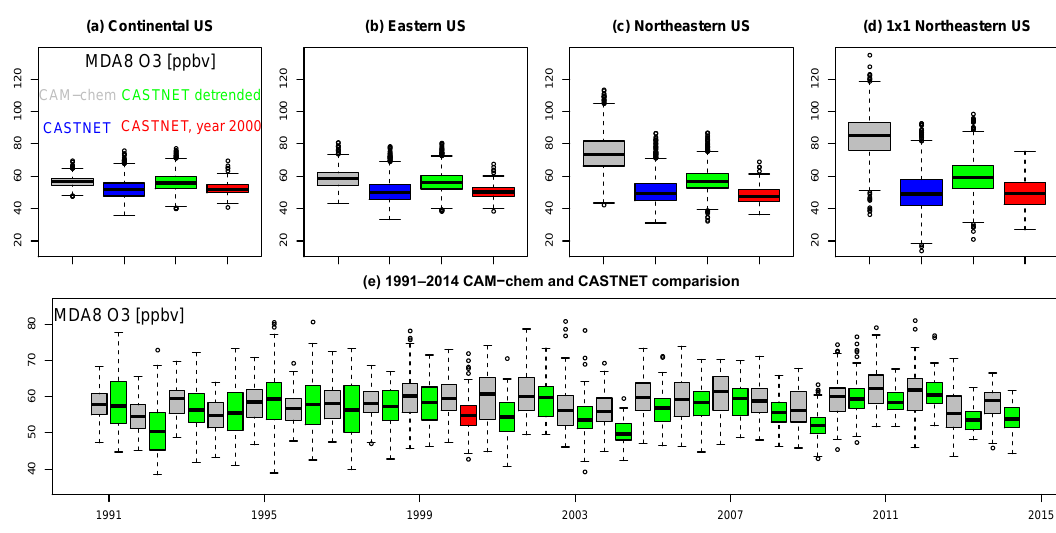
Figure 3. (a–d) : Box plots for surface MDA8 O 3 for every summertime (JJA) day from 1991 to 2014 averaged over the continental US, the eastern US, the northeastern US, and a single grid cell in the northeastern US from CAM-chem (grey), CASTNET observations (blue), detrended CASTNET observations centered at the year 2000 (green), and, since the CAM-chem simulations have cycled year-2000 emissions and boundary conditions, the CASTNET values for the year 2000 only (red). (e) Comparison of the yearly JJA MDA8 O 3 estimates averaged over the eastern US for CAM-chem (grey) and the detrended CASTNET (green) from 1991 to 2014. The single red box plot coincides with the red box plot in (b) . The units are inppbv and for each box plot the box contains the interquartile range (IQR); the horizontal line within the box is the median; and the whiskers extend out to the farthest point, which is within 1.5 times the IQR with circles indicating any outliers.